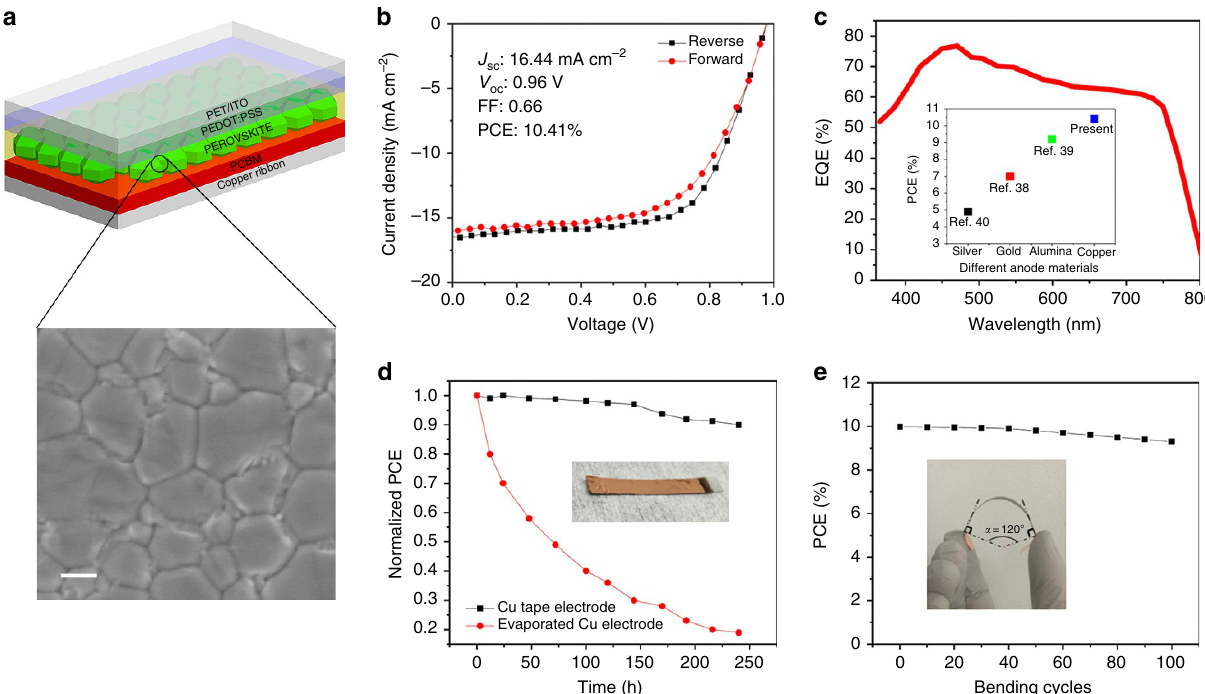
Figure 3 | Device performance of perovskite solar cell with respective device structures. ( a ) The schematic of a flexible perovskite solar cell with Cu tape anode. Zoomed-in region of the perovskite layer represents SEM image of perovskite grain crystal with 1 m m crystal grain size. Scale bar, 500nm. ( b ) I–V curve of the best device under 1sun conditions (100mWcm (cid:2) 2 , AM 1.5G). ( c ) EQE versus wavelength for the device; inset shows a comparison of the present PCE with other reported inverted flexible PSC using different thermal evaporated negative electrodes. ( d ) Normalized PCE of PSC made with Cu tape electrode and thermally evaporated Cu electrodes after being stored in air for 240h. ( e ) PCE stability based on the bending cycles for PSCs with a 120 (cid:2) angle; inset shows the photograph of the bending process and angle determination. NATURE COMMUNICATIONS|7:13319|DOI: